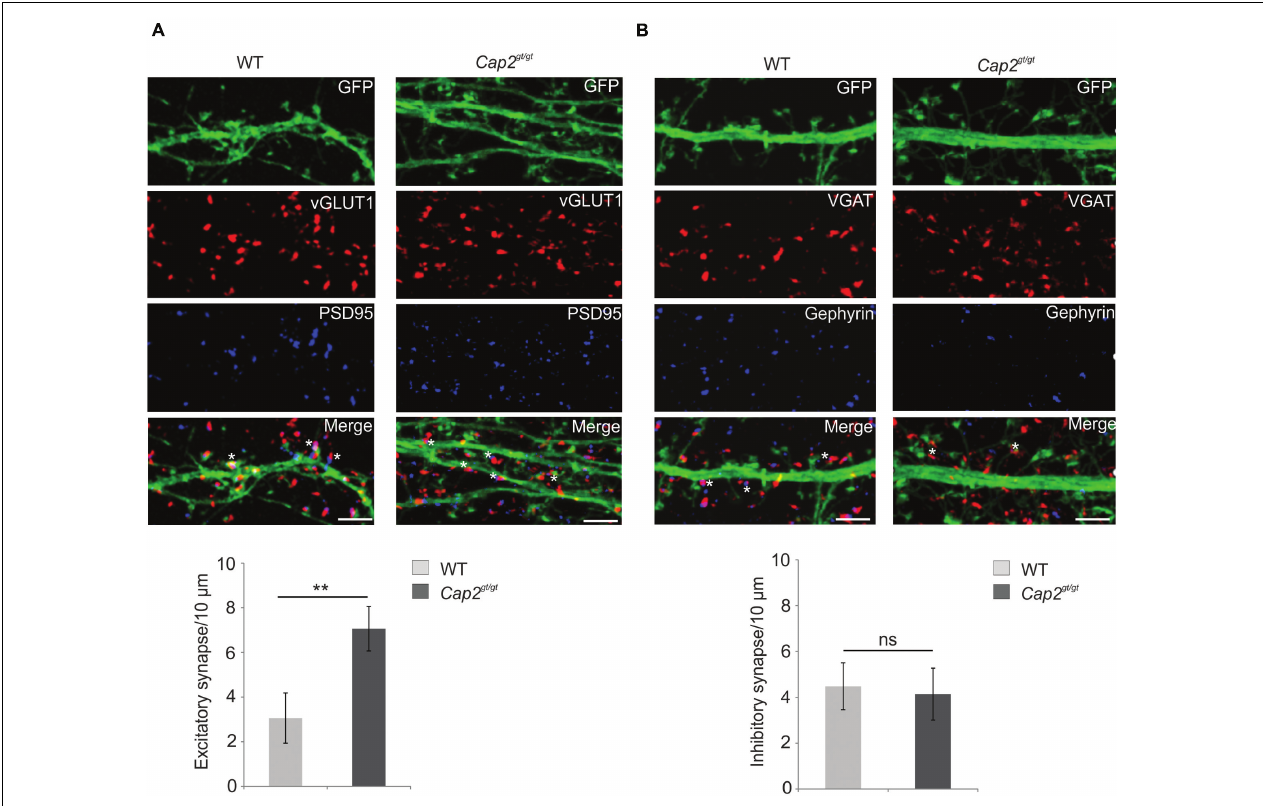
FIGURE 4 | (A) pEGFP-C2 transfected primary cortical neurons at div 16 labeled with antibodies against vGLUT1 (a presynaptic marker, red) and PSD-95 (a postsynaptic marker, blue). An increase in excitatory synapse (white asterik) was observed in CAP2 mutant neurons (WT: 3.1 ± 1.1 synapses/10 µ m, n = 20 neurons from 4 experiments; Cap2 gt / gt : 7.1 ± 1.0 synapses/10 µ m, n = 20 neurons from 3 experiments, p < 0.01). Scale bar, 5 µ m. (B) pEGFP-C2 transfected primary cortical neurons at div 16 labeled with antibodies against VGAT (an inhibitory presynaptic marker, red) and gephyrin (an inhibitory postsynaptic marker, blue). There is no significant difference in inhibitory synapses (white asterisk) in CAP2 mutant neurons (WT: 4.5 ± 1.0 synapses/10 µ m, n = 20 neurons from 4 experiments; Cap2 gt / gt : 4.1 ± 1.1 synapses/10 µ m, n = 20 neurons from 3 experiments, p > 0.05). Scale bar, 5 µ m. ∗∗ p < 0.01.